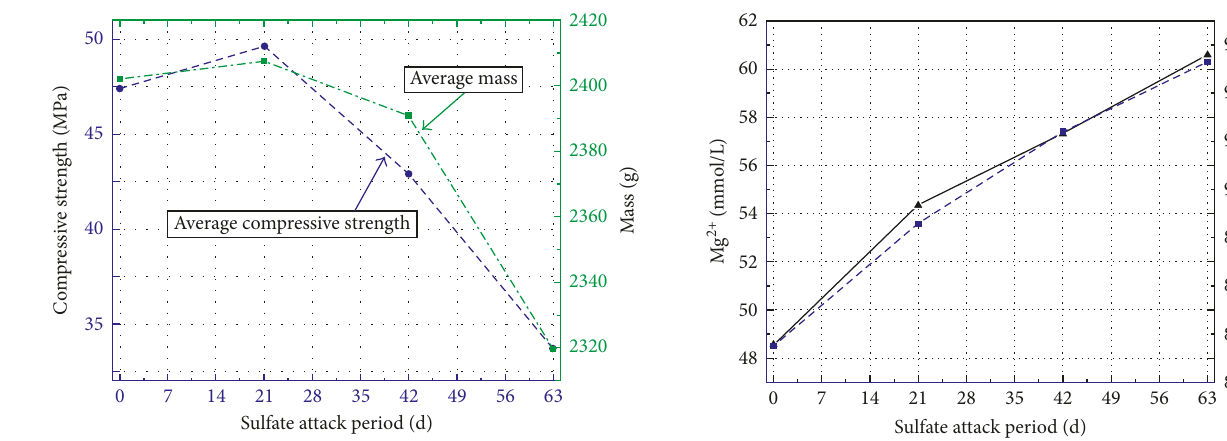
Figure 10: The variation of mass and compressive strength in concrete exposed to drying-wetting cycles with sulfate attack.